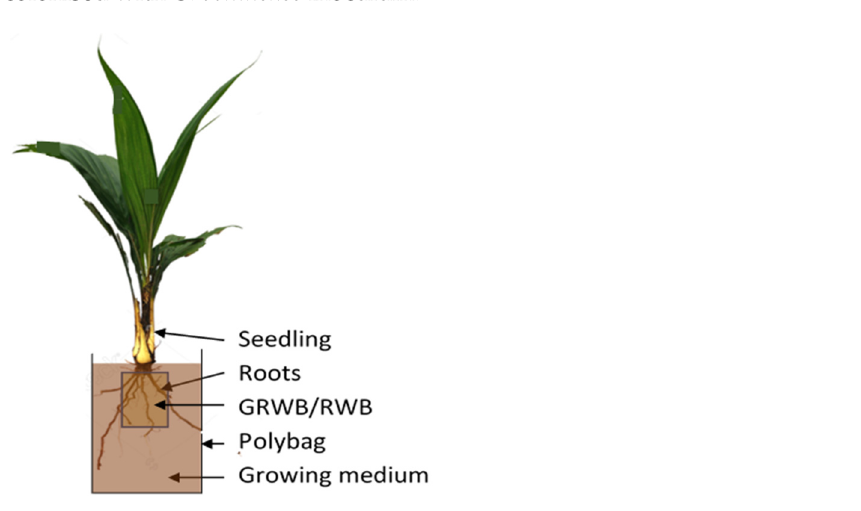
Figure 2. Position of drippers and MEC10 sensors. 2.2. Physical Growth Measurement There were four physical parameters measured during the study, namely chlorophyll content, measured using a Chlorophyll Meter SPAD ‐ 502 (Konica Minolta, Osaka, Japan); frond count, using manual counting; girth, using digital Vernier callipers (Mitutoyo Dig ‐ ital Calliper, Kanagawa, Japan); and height, using a measuring tape. The measurements were conducted every two weeks over the study period, where the first measurement was conducted immediately after transplanting as the initial growth of the seedlings.